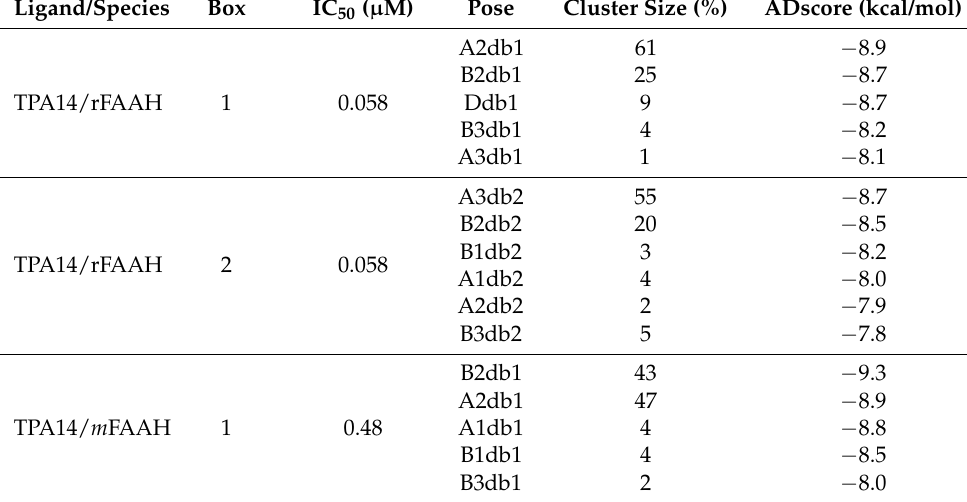
Table 1. Docking results of TPA14 in r FAAH and m FAAH. Capital letters indicate TPA14 orientation concerning the CT: A-pose, amide bond closer to the CT; B-pose, trifluoromethyl-pyridine ring closer to the CT; D-pose binds diagonally with respect to the CT. Numbers indicate the proximity from the catalytic triad; the lower the number, the higher the proximity; db1 and db2 indicate whether the binding solution was retrieved from docking box1 or docking box2,